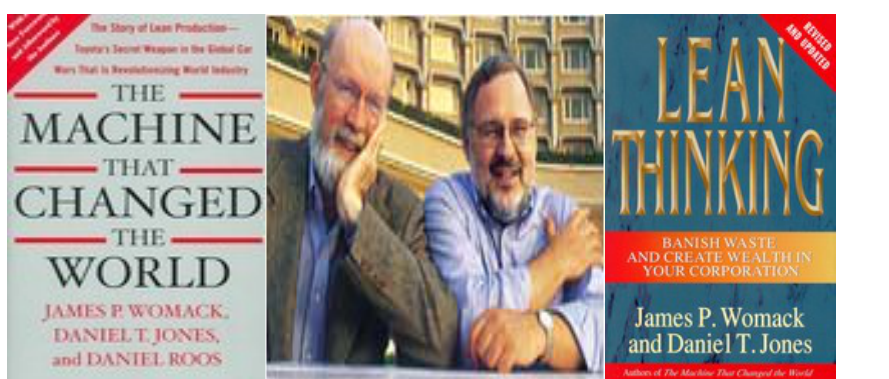
Figure 1 – Authors of books, James P. Womack and Daniel T. Jones Рис . 1 – Авторы книг , James P. Womack и Daniel T. Jones Slika 1 – Autori knjiga su James P. Womack i Daniel T.